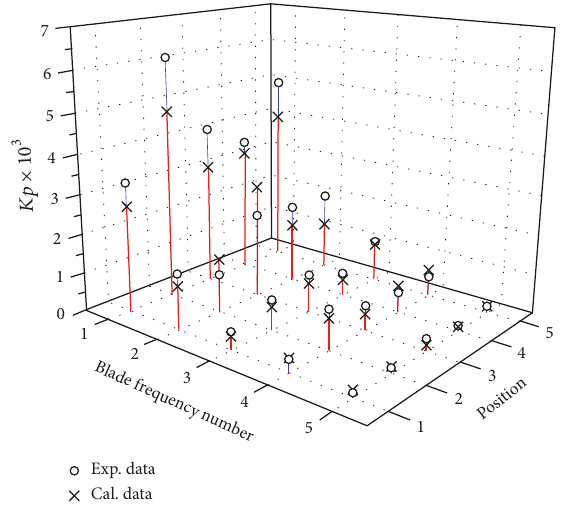
Figure 8: Comparisons between the experiment values and calcu- lation results of 2nd propeller.